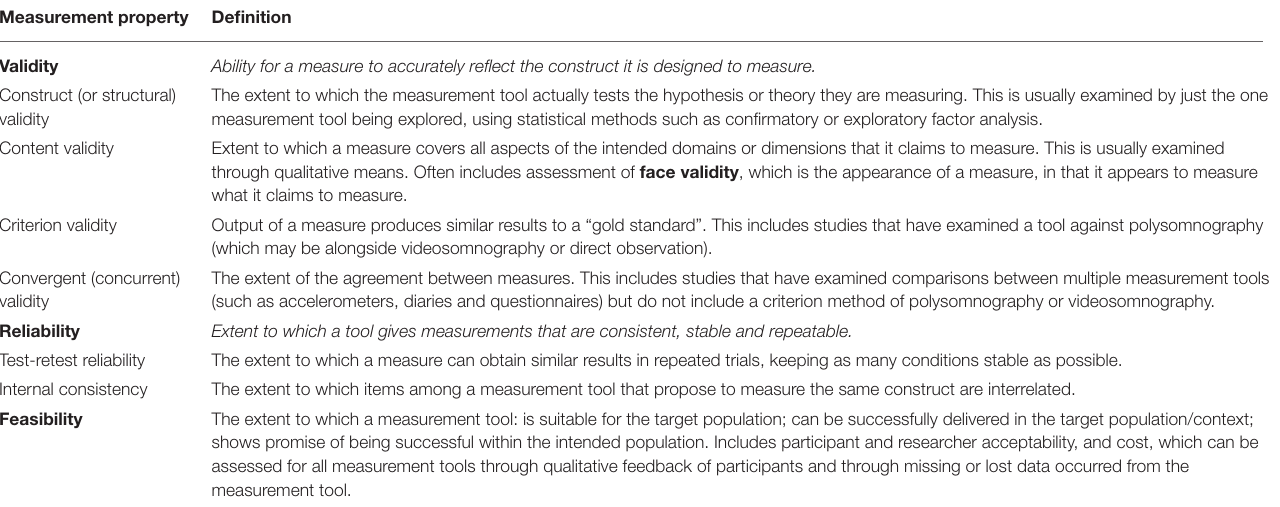
TABLE 1 | Definition of each of the measurement properties included in this